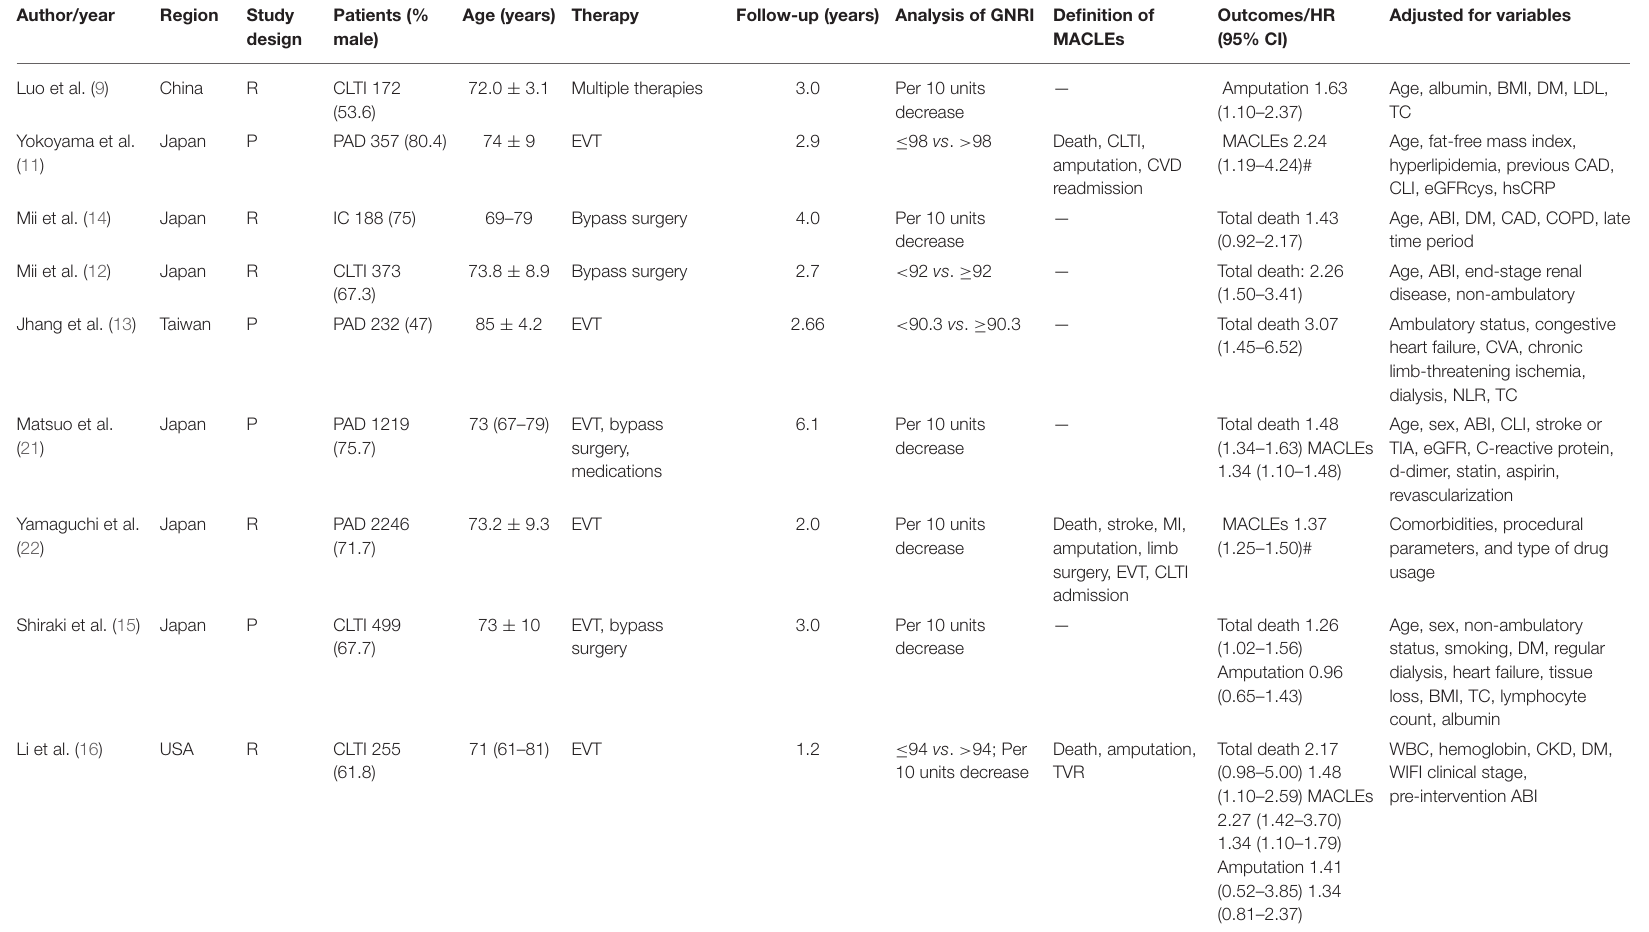
HR, hazard ratio; CI, confidence intervals; SD, standard deviation; R, retrospective; P, prospective; PAD, peripheral artery disease; EVT, endovascular therapy; GNRI, geriatric Nutritional Risk Index; MACLEs, major adverse cardiovascular and leg events; ABI, ankle-brachial index; TVR, target vessel revascularization; hsCRP, high-sensitivity C-reactive protein; Cys, cystatin C; CLTI, chronic limb threatening ischemia; IC, intermittent claudication; CVA, cerebrovascular accident; TIA, transient ischemic attack; NLR, neutrophil-lymphocyte ratio; MI, myocardial infarction; CAD, coronary artery disease; COPD, chronic obstructive pulmonary disease; CKD, chronic kidney disease; WBC, white blood cell; WIFI, wound, ischemia, and foot infection; TC, total cholesterol; CVD, cardiovascular disease; BMI, body mass index; DM, diabetes mellitus; eGFR, estimated glomerular filtration rate; # Results pooled from subgroups using a fixed-effect